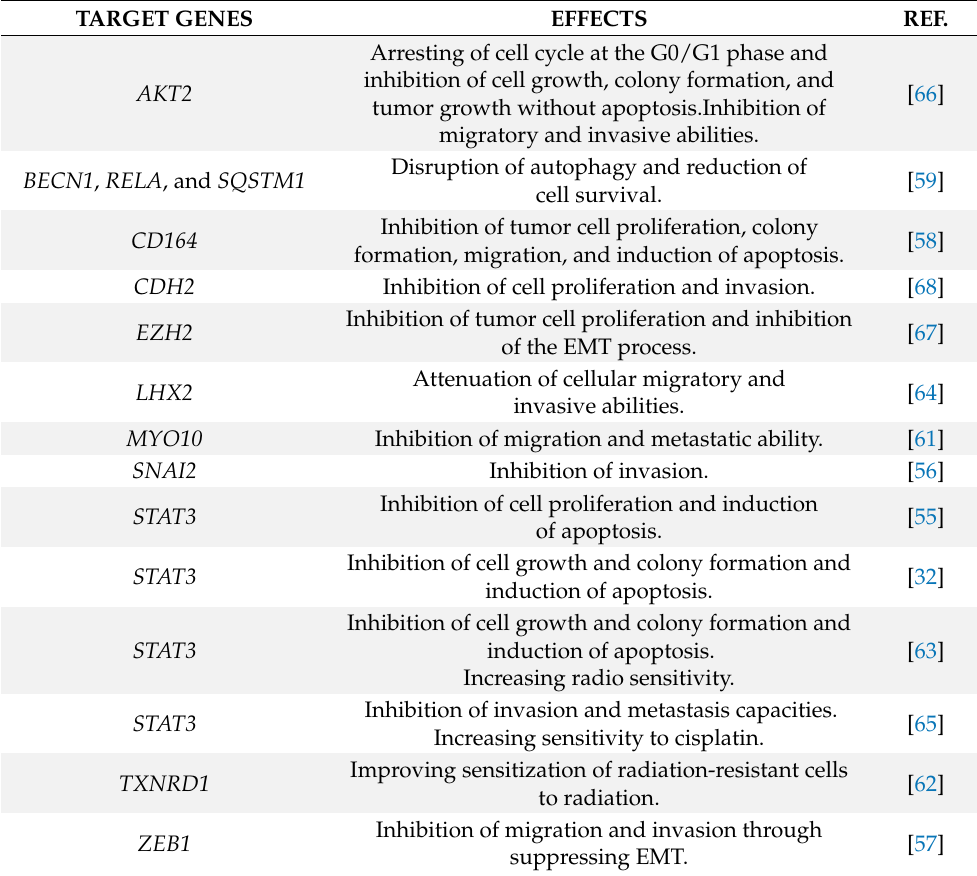
Table 2. Anti-tumor function of miR-124 in lung